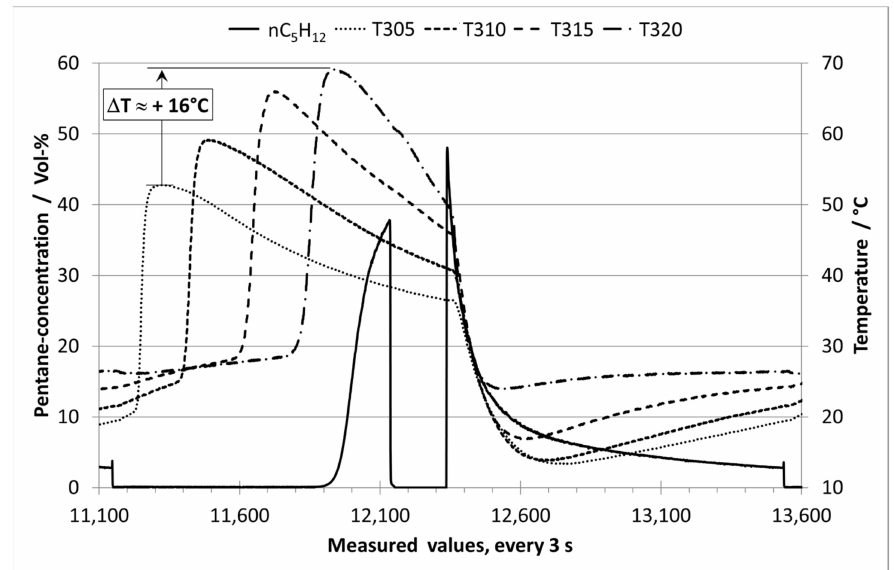
Figure 8. Concentration and temperature profile in the filter for E10/humid N 2 in 10th